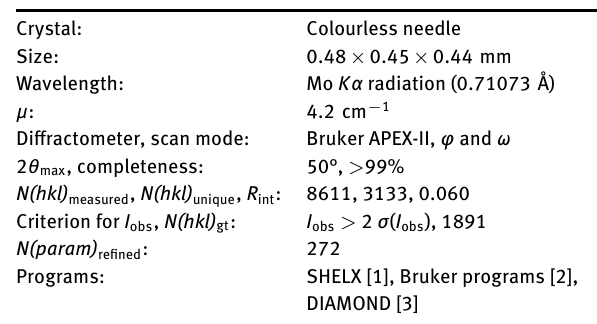
Table 1: Data collection and handling.